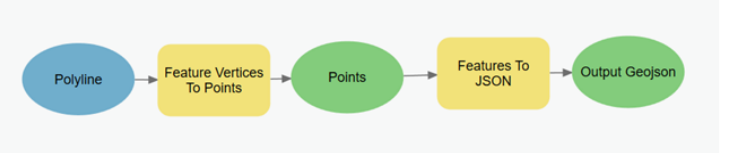
Figure 7. Processing polyline data into ArcGIS Pro to get Geojson files (Created with ArcGIS Pro model builder).